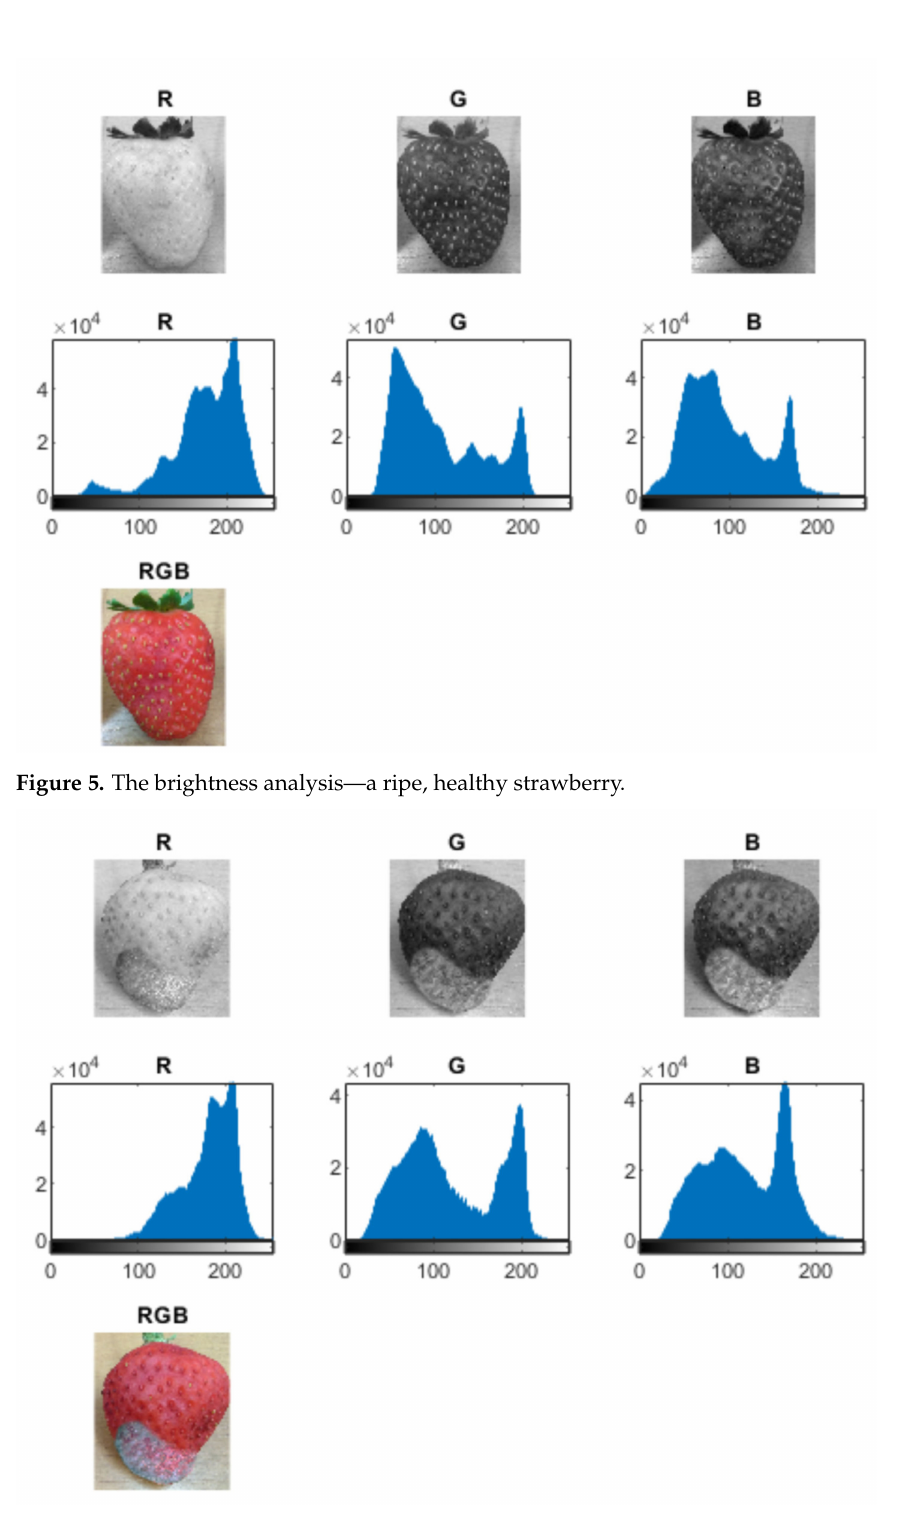
Figure 6. The brightness analysis—mouldy fruit. The fruit that is mechanically damaged, for example, when gnawed by a snail, may only have a changed shape without changing its colour—see Figures